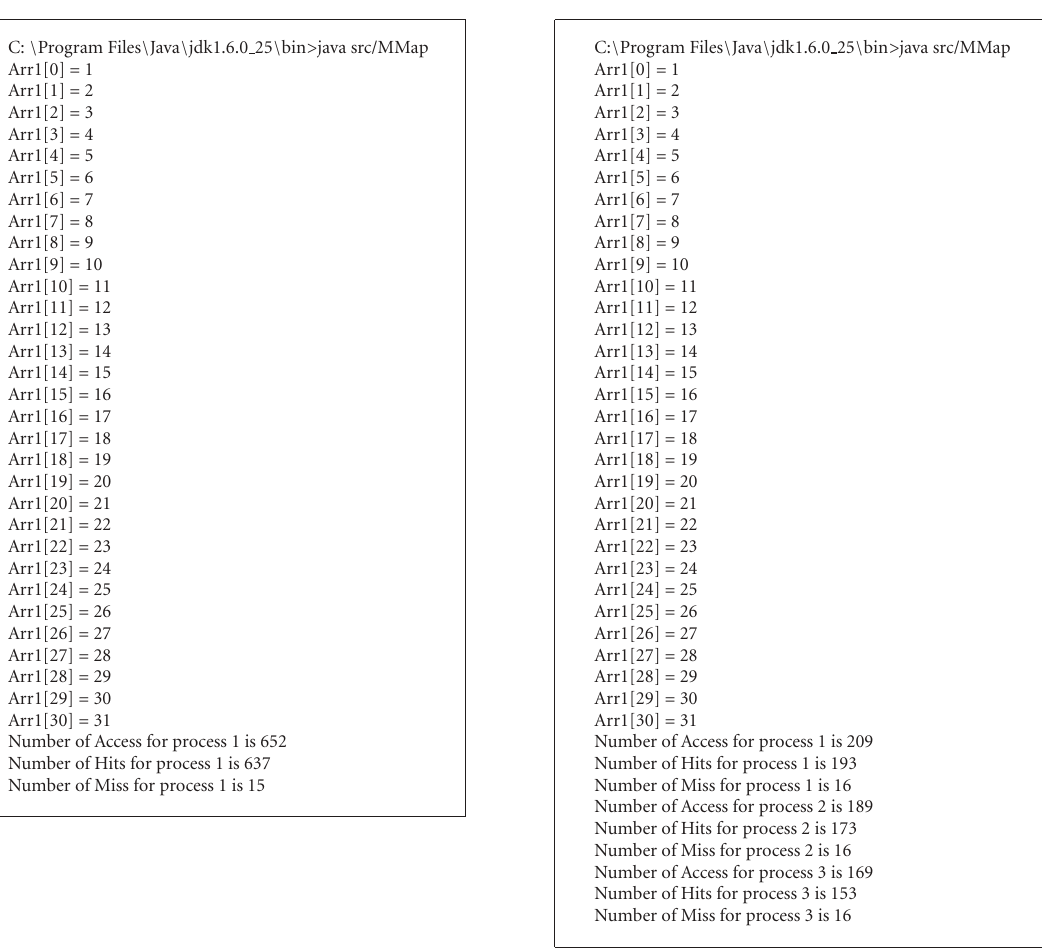
Figure 8: Screen shots for plain and interleaved merge sort execution on memory map simulator block size of 128 bits.